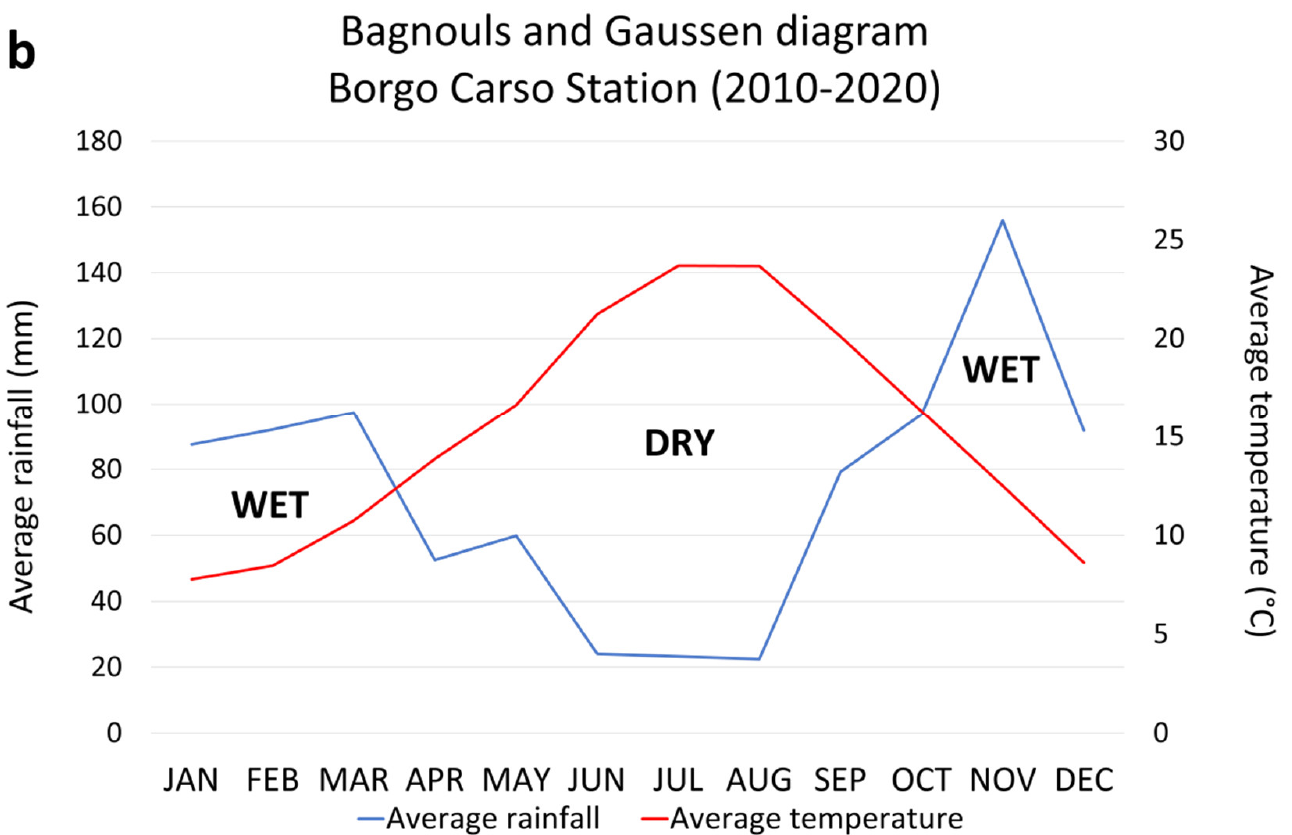
Figure 2. Bagnouls and Gaussen diagram for ( a ) Latina meteorological station (owned by the Regional Functional Center of the Civil Protection of Lazio and representative for the urban area climate condition) and ( b ) Borgo Carso Station (owned by Integrated Agrometeorological Desk of the Lazio Region—SIARL—and representative of the outlying rural suburbs). Table 1. The monthly cumulative precipitation (P) and the monthly temperature (T) in Latina and B. Carso (2010–2020).